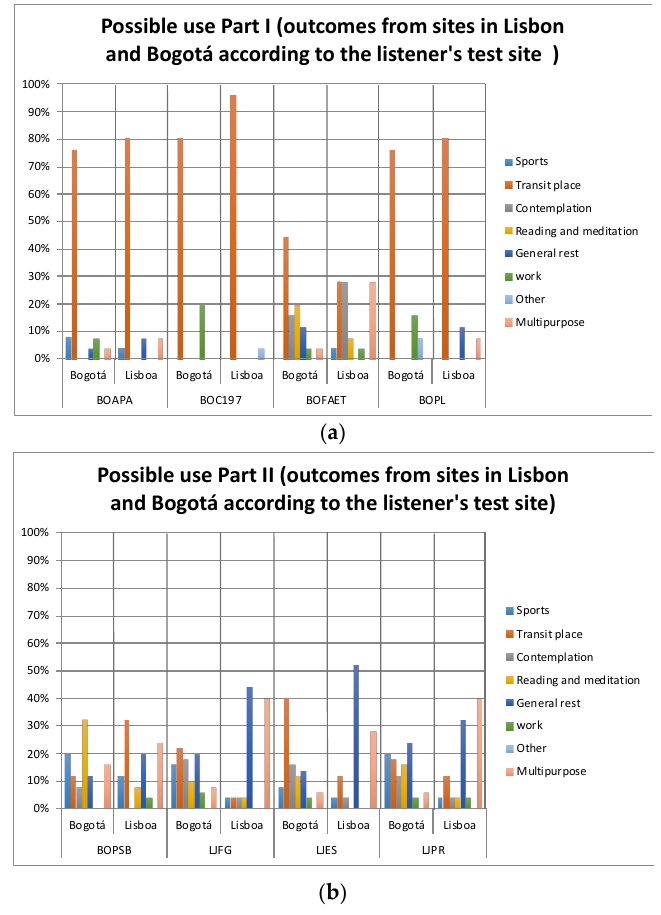
Figure 7. ( a ) Possible use that might be given by the evaluators in places with acoustic environments such as the ones presented in the recordings (Part I); ( b ) Possible use that might be given by the evaluators in places with acoustic environments such as the ones presented in the recordings (Part II). Table 3. X 2 and the likelihood-ratio tests with a = 0.05 for the eight soundscapes for both the evaluators from Bogotá and from Lisbon. Green values represent statistically significant association between the outcomes and the listener origin.